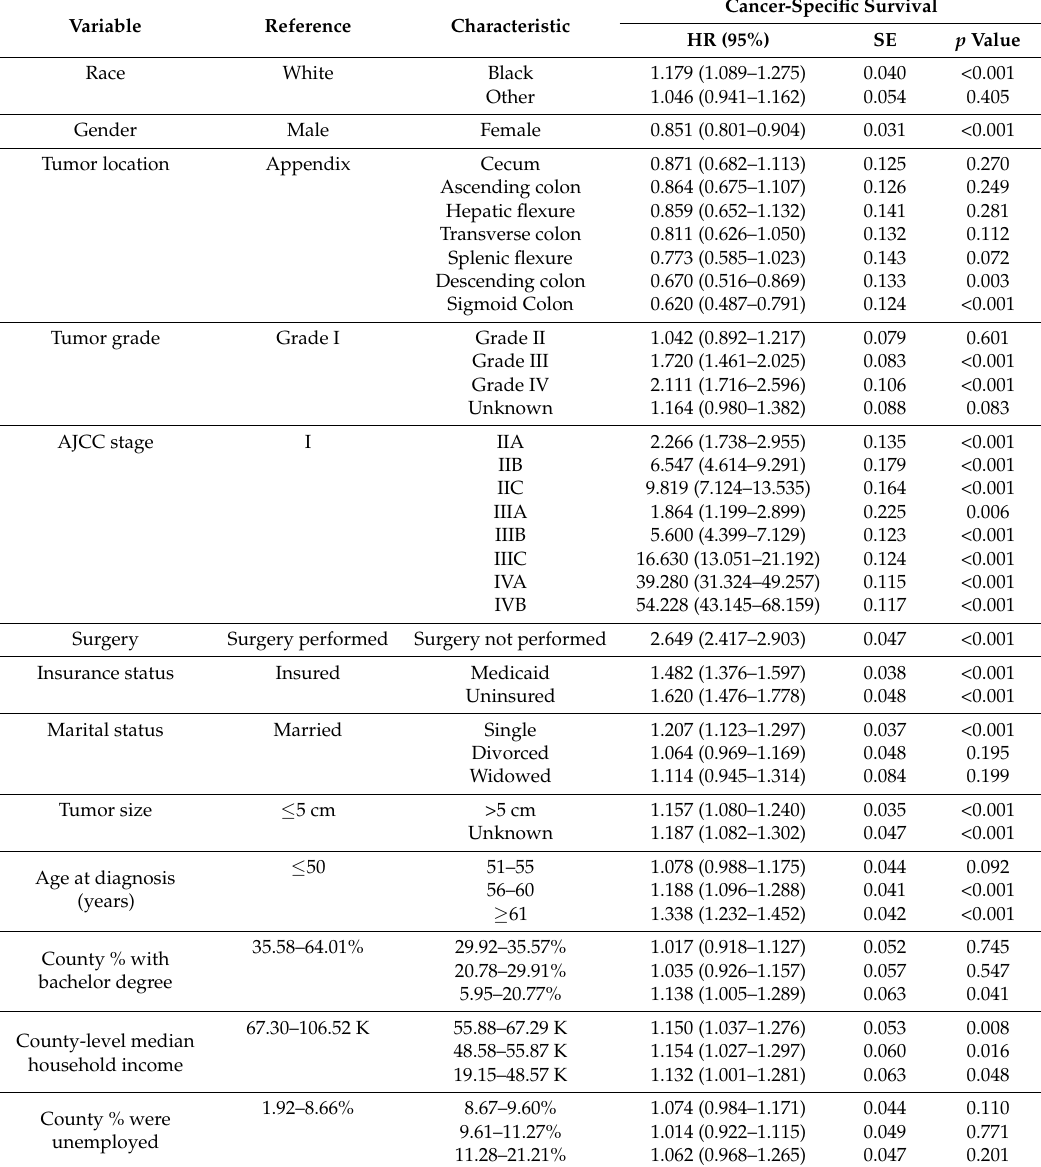
Table 2. Multivariate Cox regression analyses of